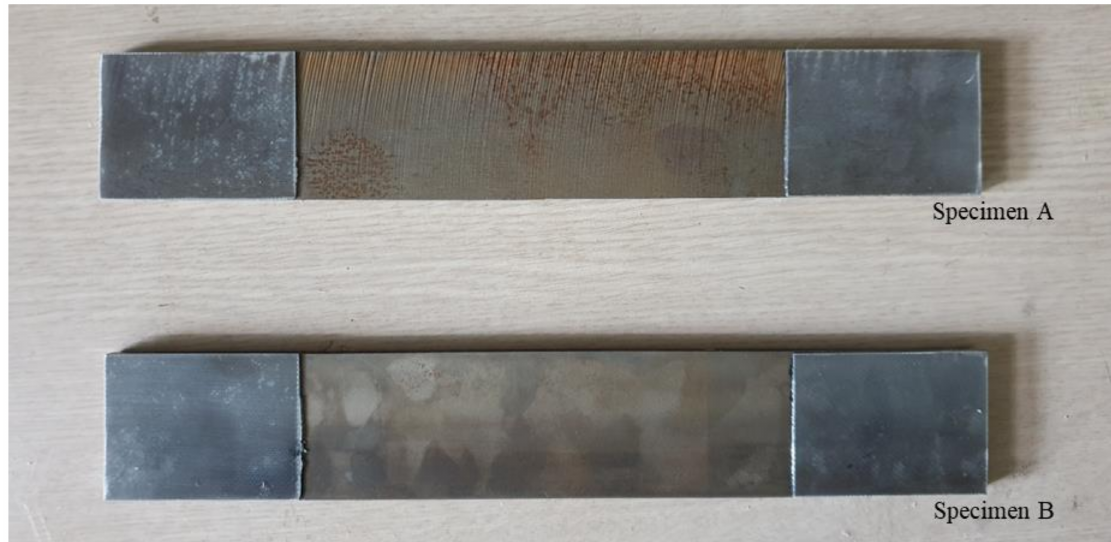
Figure 4. Photograph of specimens manufactured for the tensile